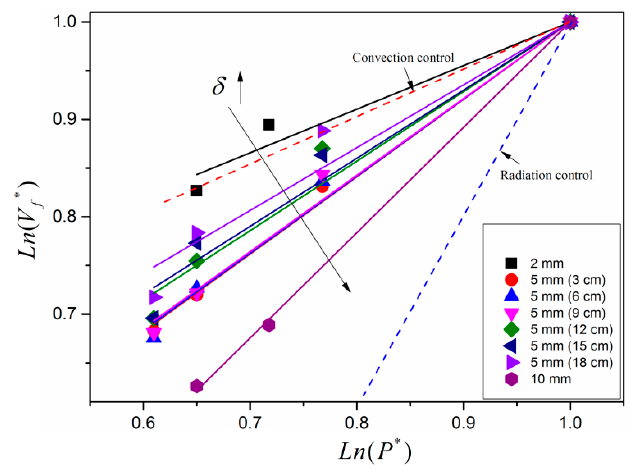
Figure 7. Fitted relationships between flame spread rate and pressure for different sized samples. The horizontal and vertical coordinates are the values of non-dimensional pressure ( P ∗ ) and non-dimensional flame spread rate ( V f ∗ ) after